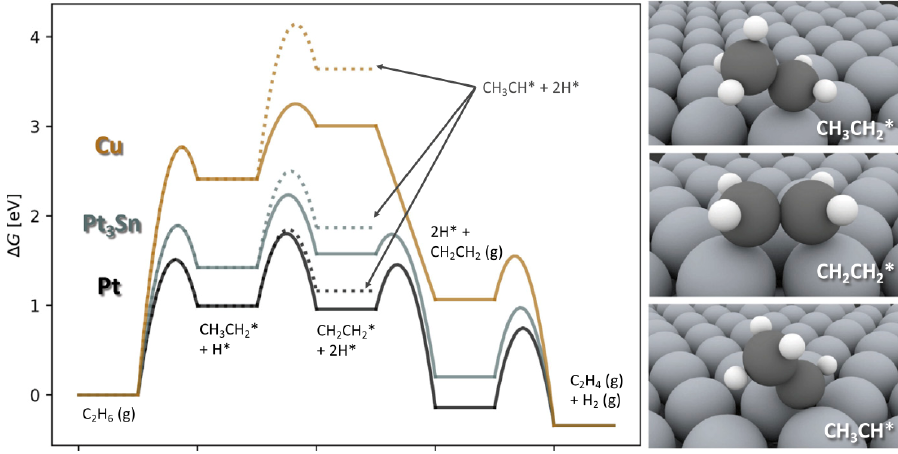
Figure 3. Free energy diagrams (at 873 K, 0.2 bar C 2 H 6 , 2 · 10 − 4 bar C 2 H 4 , (0.1% carbon conversion), and 0.6 bar H 2 ) are presented. Solid lines represent the most relevant pathway in ethane conversion to ethylene, and dotted lines the elementary step to CH 3 CH*. Pathways are drawn for three different catalysts, Cu, Pt 3 Sn and Pt. Atomic structures are shown in the right panel (large gray spheres = surface atoms, black spheres = C atoms, small white spheres = H atoms). (Reprinted with permission from [6]. Copyright 2019